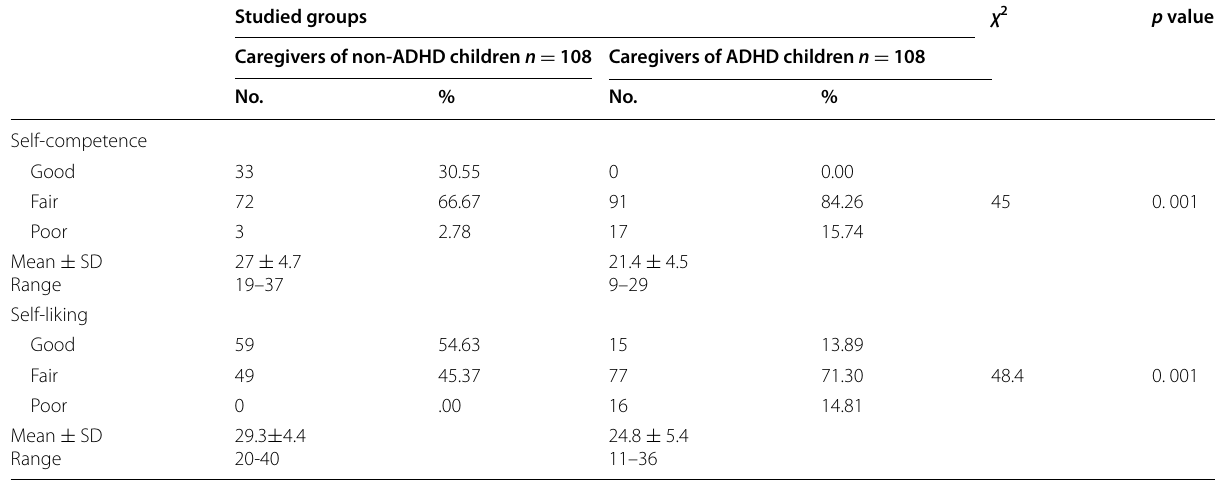
Table 3 Comparison between caregivers of non‑ADHD children and ADHD children regarding self‑competence and self‑liking (each group 108) =